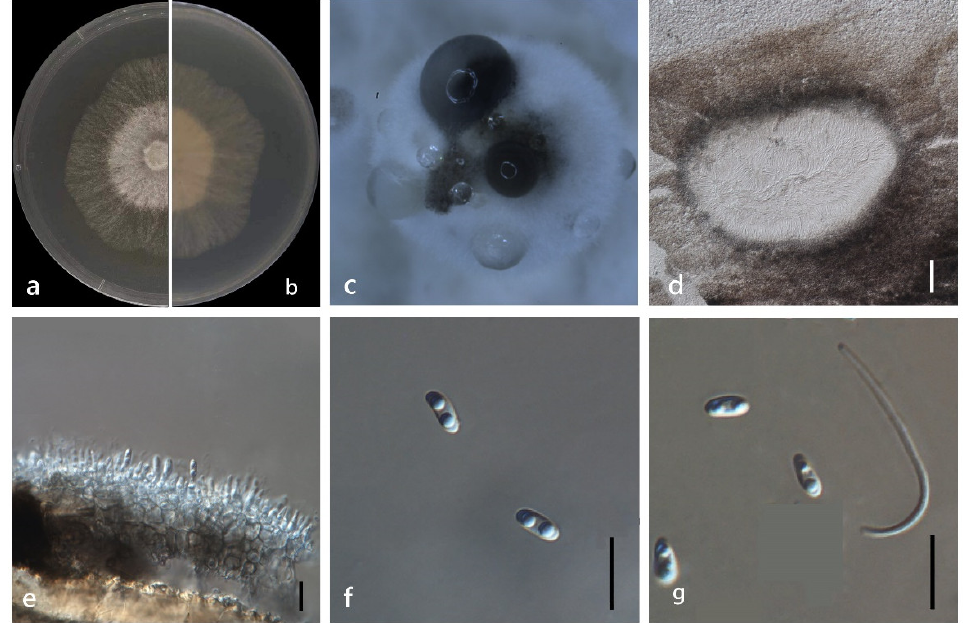
Figure 12. Diaporthe siamensis (ZHKUCC 22-0049) ( a ) upper view of colonies on PDA; ( b ) Reverse view of colonies on PDA; ( c ) Pycnidia with conidial droplets on PDA; ( d ) Section of pycnidia; ( e ) Conidiogenous cells; ( f , g ) Alpha and beta conidia. Scale bars: ( d ) =100 µm; ( e – g ) =10 µm.